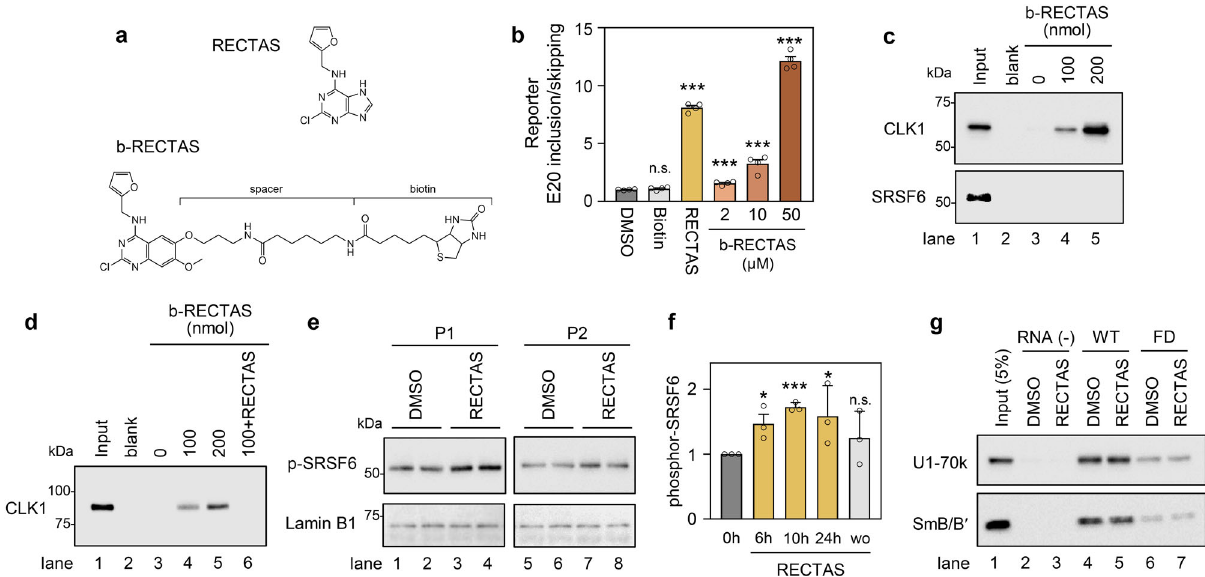
Fig. 3 RECTAS directly interacts with CDC-like kinase 1 (CLK1), and it enhances cellular SRSF6 activity. a Structures of RECTAS and b-RECTAS. b Extent of IKBKAP -FD exon 20 inclusion represented by GFP/RFP ratio, following treatment with biotin (50 µ M), RECTAS (2 µ M), b-RECTAS (2, 10, and 50 µ M), or solvent only (0.1% DMSO) for 24 h in reporter-transfected HeLa cells. c , d Western blotting of pull-down products by b-RECTAS (0, 100, or 200 nmol/ reaction) for HeLa cells transfected with a fl ag-tagged CLK1 expression vector ( c ) or GST-tagged recombinant CLK1 ( d ). RECTAS (500 nmol) was incubated with 100 nmol b-RECTAS for the competition assay in ( d ). e , f Western blot ( e ) for phosphor SRSF6 in FD patient primary fi broblasts (P1 and P2), treated with RECTAS (10 µ M) or solvent only (0.1% DMSO) for 24 h. f Phosphor SRSF6 in FD fi broblasts (P1) was quanti fi ed at 0, 6, 10, 24 h after RECTAS (10 µ M) treatment (columns, 0 h, 6 h, 10 h, and 24 h), as well as 10 h after washout of compound following RECTAS treatment (10 µ M) for 24 h (column, wo). Lamin B1 served as a loading control in ( e ). g Western blot for U1-70k and SmB/B ’ in pull-down products with biotin-conjugated RNA surrounding IKBKAP exon 20 donor site with (oAM154) or without (oAM153) IVS20 + 6 T > C mutation (labeled as FD and WT, respectively). Pull-down was conducted in the presence of 10 µ M RECTAS with 1% DMSO, or 1% DMSO only. RNA ( − ), control sample without RNA bait. Input, HeLa nuclear extract of 5% input amount. Representative data from four replicates were shown in ( b ). Representative data from two replicates were shown in ( c ), ( d ), and ( g ). Data from two experiments are shown in ( e , f ) and three experiments are shown in ( f ). Columns, mean; bars, SE; n.d. ≥ 0.05; * P < 0.05; *** P < 0.001 for unpaired two-tailed t test in ( b ) (biotin, P = 0.26; RECTAS, P = 2.5 × 10 − 8 ; b-RECTAS 2 µ M, 5.5 × 10 − 4 ; b-RECTAS 10 µ M, 7.5 × 10 − 4 ; b-RECTAS 50 µ M, 9.6 × 10 − 8 ) and one-tailed t test in ( f ) (vs. the 0 h control: 6 h, P = 1.6 × 10 − 2 ; 10 h, P = 2.8 × 10 − 5 ; 24 h, P = 4.8 × 10 − 2 ; wo, P = 0.18). No sample was loaded in blank lanes in ( c , d